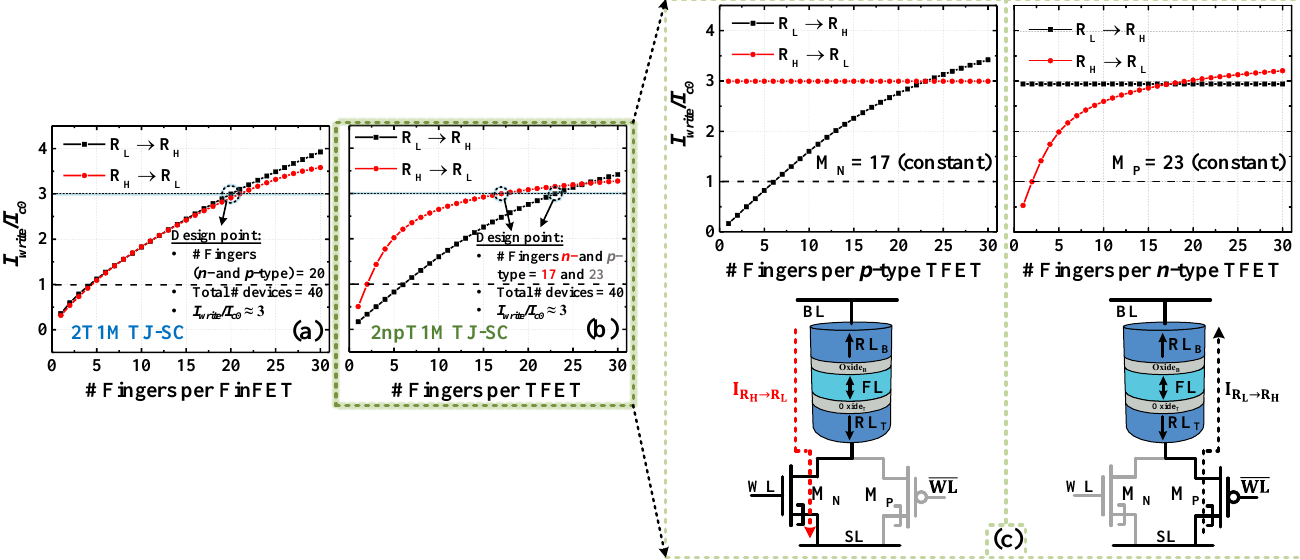
Figure 5. Ratio between write current ( I write ) and I c 0 as functions of the number of fingers per device for ( a ) 2T1MTJ-SC, and ( b ) 2npT1MTJ-SC configurations. ( c ) I write / I c 0 as function of number of fingers per p -type (M P ) and n -type (M N ) TFET, while maintaining M N and M P constant,